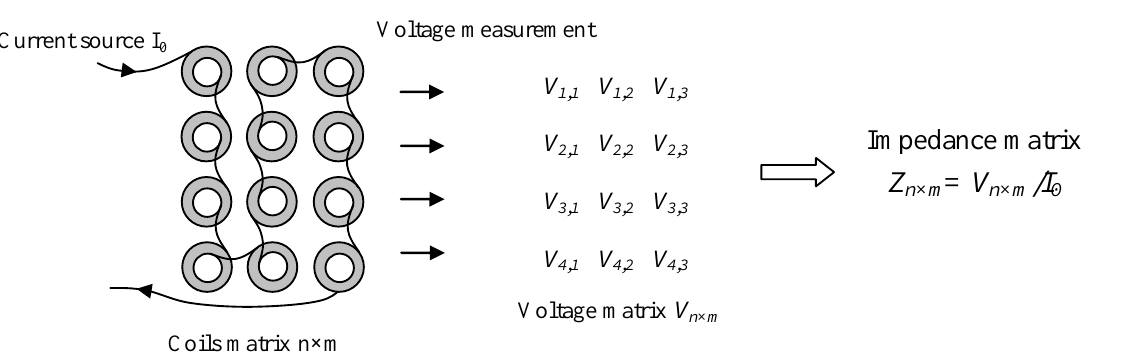
Figure 2. Impedance matrix